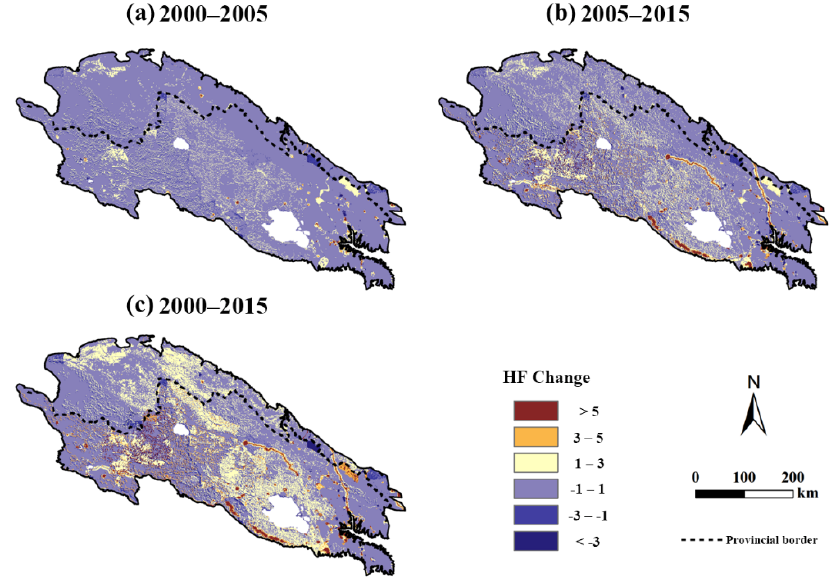
Figure 5. Change in the HF over the QLM: ( a ) change in the HF for 2000–2005; ( b ) change in the